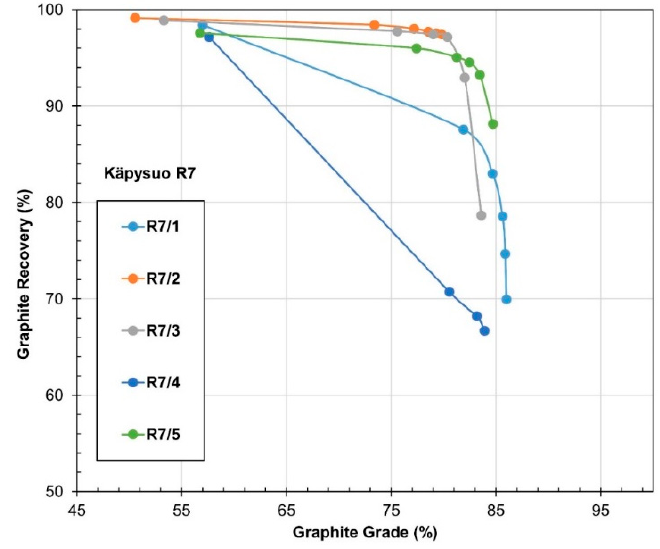
Figure 7. FC grade and recovery curves graph for the five R7 flotation tests. The points represent the FC grade and recovery in each flotation stage. The first points in the curves represent the rougher flotation and the following ones, the cleaners. Table 4. Results of flotation tests after fifth cleaning stage (CC5).